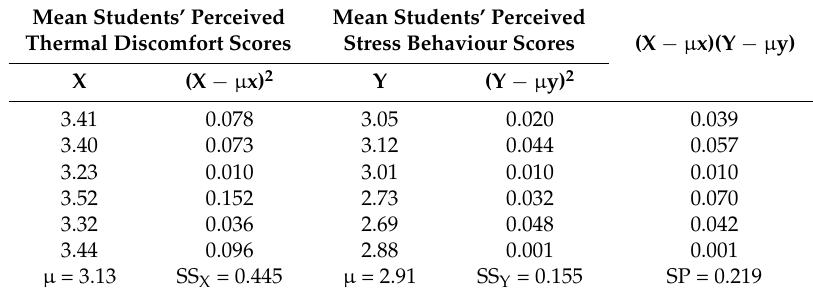
Table 6. Test of correlation between students’ perceived thermal discomfort level and students’ perceived stress behaviour level affecting learning in